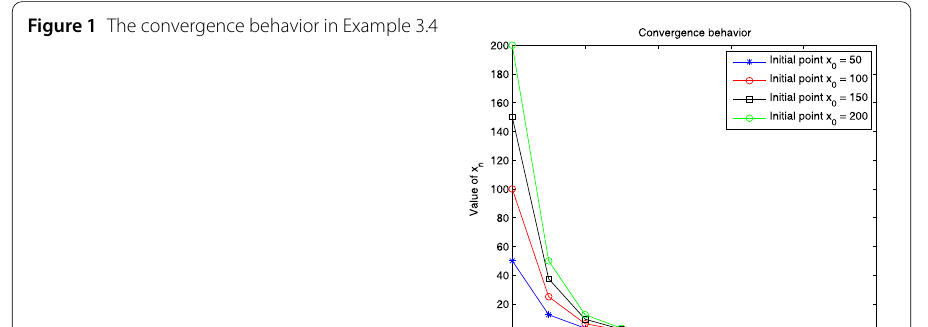
Figure 1 The convergence behavior in Example